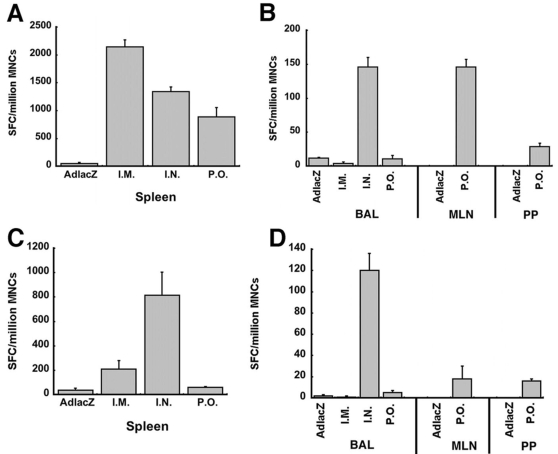
Pre-Existing Immunity Against Adenovirus Does Not Compromise the Systemic or Mucosal Cellular Response Generated Against Ebola Glycoprotein After Intranasal Immunization.The frequency of IFN-γ positive mononuclear cells was analyzed from the spleen (panels A and C), the lung via bronchioalveolar lavage (BAL) and the intestine via the mesenteric lymph nodes (MLN) and Peyer's patches (PP) (panels B and D) 45 days post-immunization by ELISPOT. Samples were obtained from naïve animals (Panels A and B) and those with pre-existing immunity to adenovirus serotype 5 (Panels C and D). Cells were plated at 1×105 or 1×104 cells per well, stimulated with the TELRTFSI peptide and expression of IFN-γ detected with an anti-mouse IFN-γ antibody. Cells isolated from BAL, MLN or PP of four mice were pooled and samples tested in duplicate. In each panel, the number of spot-forming cells (SFC) per million mononuclear cells (MNCs) is shown on the y-axis. Please note - the scale of this axis differs between panels to accent the differences between treatment groups. Error bars represent the standard deviation of the data. Animals immunized with an irrelevant adenoviral vector (AdlacZ) served as negative controls. Positive results obtained from this group are indicative of artificial cellular stimulation that may have occurred during processing and culturing of samples.